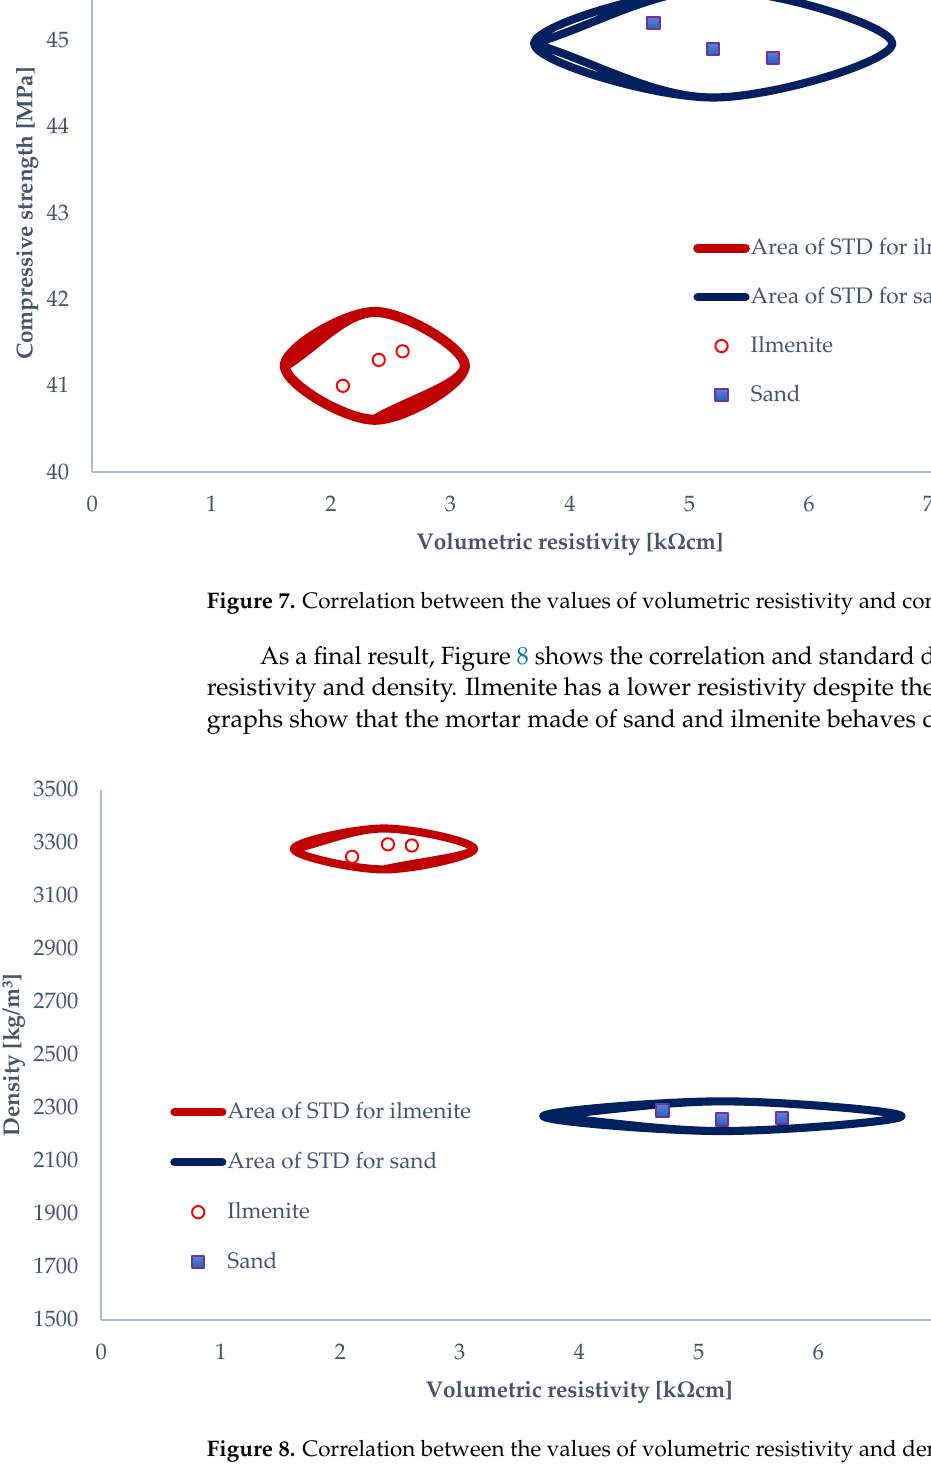
Figure 6. Correlation between the values of surface resistivity and volumetric resistivity.